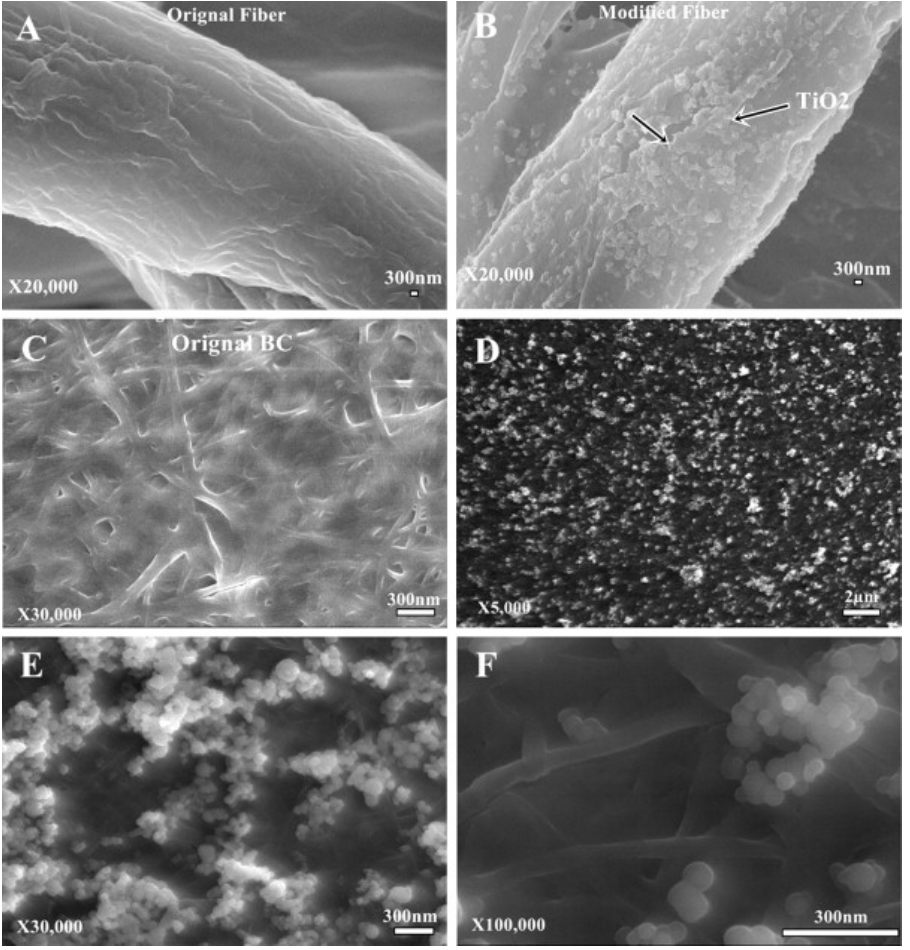
Figure 4. SEM images of unmodified fibers of cellulose filter paper ( A ) and after formation of CP/TiO 2 film ( B ), FEG/SEM image of original BC membrane ( C ) and after formation of CP/TiO 2 film on BC in low ( D ) and high magnification ( E , F ). Reprinted with permission of [30].